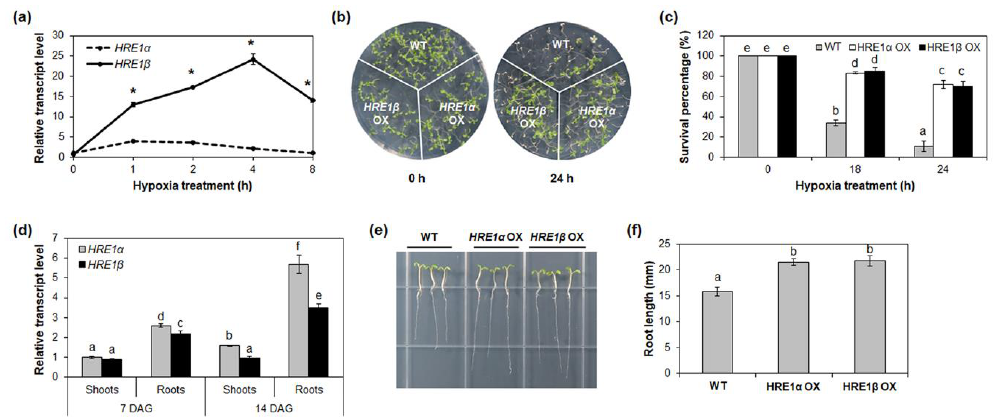
Figure 2. Hypoxia response and root development of HRE1 α and HRE1 β . ( a ) Quantitative RT-PCR analysis of HRE1 α and HRE1 β under hypoxia treatment for the indicated times. GAPc was used as an internal control. The transcript level of HRE1 α at 0 h was set to 1. The reactions of each technical replicate were performed in triplicate. Two technical replicates were measured for each biological replicate. The data shown are the means ± S.D. ( n = 6). Similar results were obtained from at least three biological replicates, with one shown here. * t -test p < 0.05. ( b ) Hypoxia response of HRE1 α OXs and HRE1 β OXs. Seven-day-old WT, HRE1 α OXs, and HRE1 β OXs were kept in the 99.99% nitrogen gas containing box under dark condition and then allowed to recover. ( c ) Survival percentages of WT, HRE1 α OXs, and HRE1 β OXs after hypoxia treatment and recovery. Thirty plants were used in each experiment. Three independent T 1 lines of HRE1 α OXs and HRE1 β OXs showed very similar results, with one shown here. ( d ) Quantitative RT-PCR analysis of HRE1 α and HRE1 β in the shoots and roots of 7- and 14-day-old seedlings. GAPc was used as an internal control. The transcript level of HRE1 α in the shoots of 7-day-old seedlings was set to 1. Reactions of each technical replicate were performed in triplicate. Two technical replicates were measured for each biological replicate. The data shown are the means ± S.D. ( n = 6). Similar results were obtained from at least three biological replicates, with one shown here. ( e ) Primary roots of WT, HRE1 α OXs, and HRE1 β OXs. ( f ) The primary root length of 7-day-old WT, HRE1 α OXs, and HRE1 β OXs. Seven-day-old seedlings grown on MS plates under SD conditions were used. The data shown are the means ± S.D. ( n = 15). Three independent T 1 lines of HRE1 α OXs and HRE1 β OXs showed very similar results, with one shown here. In ( c , d , f ), the data were analyzed with one-way ANOVA using Tukey’s multiple comparison test. Di ff erent letters indicate significant di ff erences ( p <